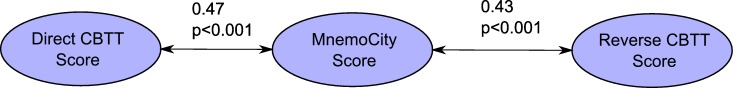
The Correlation plot.